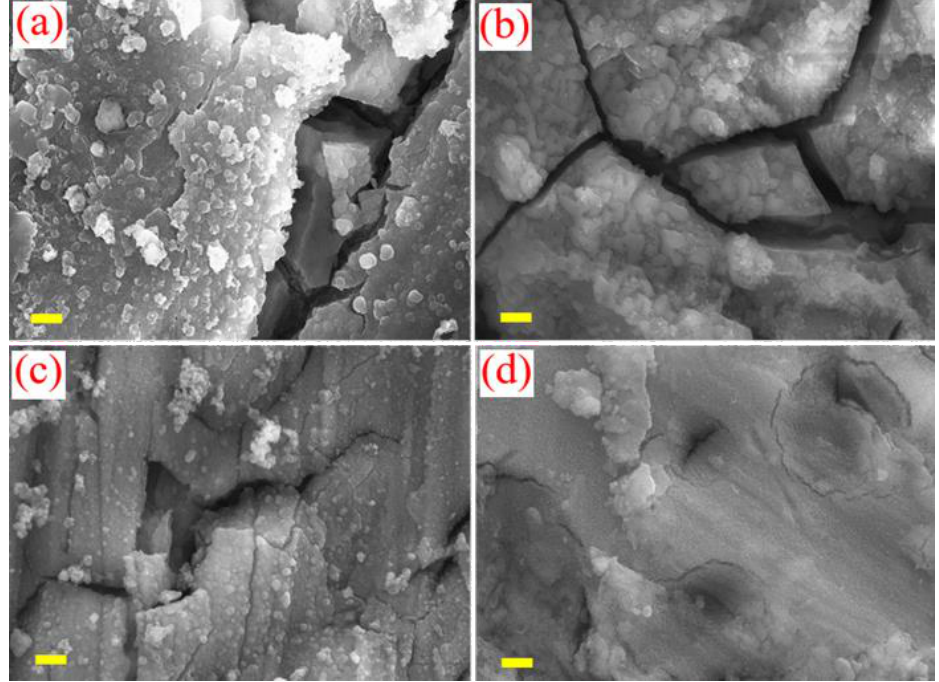
Figure 2. Representative FE-SEM surface morphology of ( a ) the pure Mg, ( b ) Mg-OH, ( c ) Mg-OH-AA, and ( d ) Mg-OH-AA-BSA, after potentiodynamic polarization test conducted in SBF solution at 37 °C. (Scale bar = 1 µm).